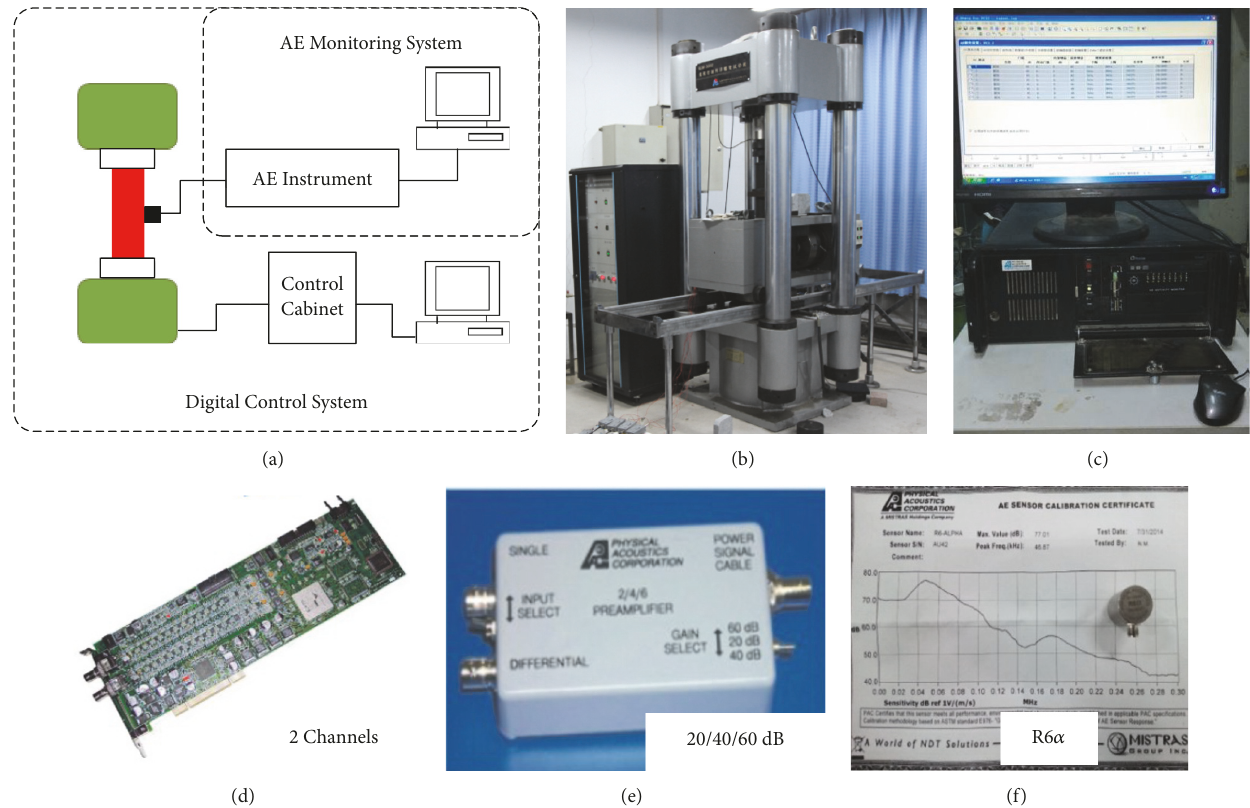
Figure 2: The experimental setup ((a) the experimental system; (b) the RLW-3000 biaxial loading system; (c) acoustic emission monitoring system of PCI-2; (d) acquisition card; (e) preamplifier; (f) sensor).